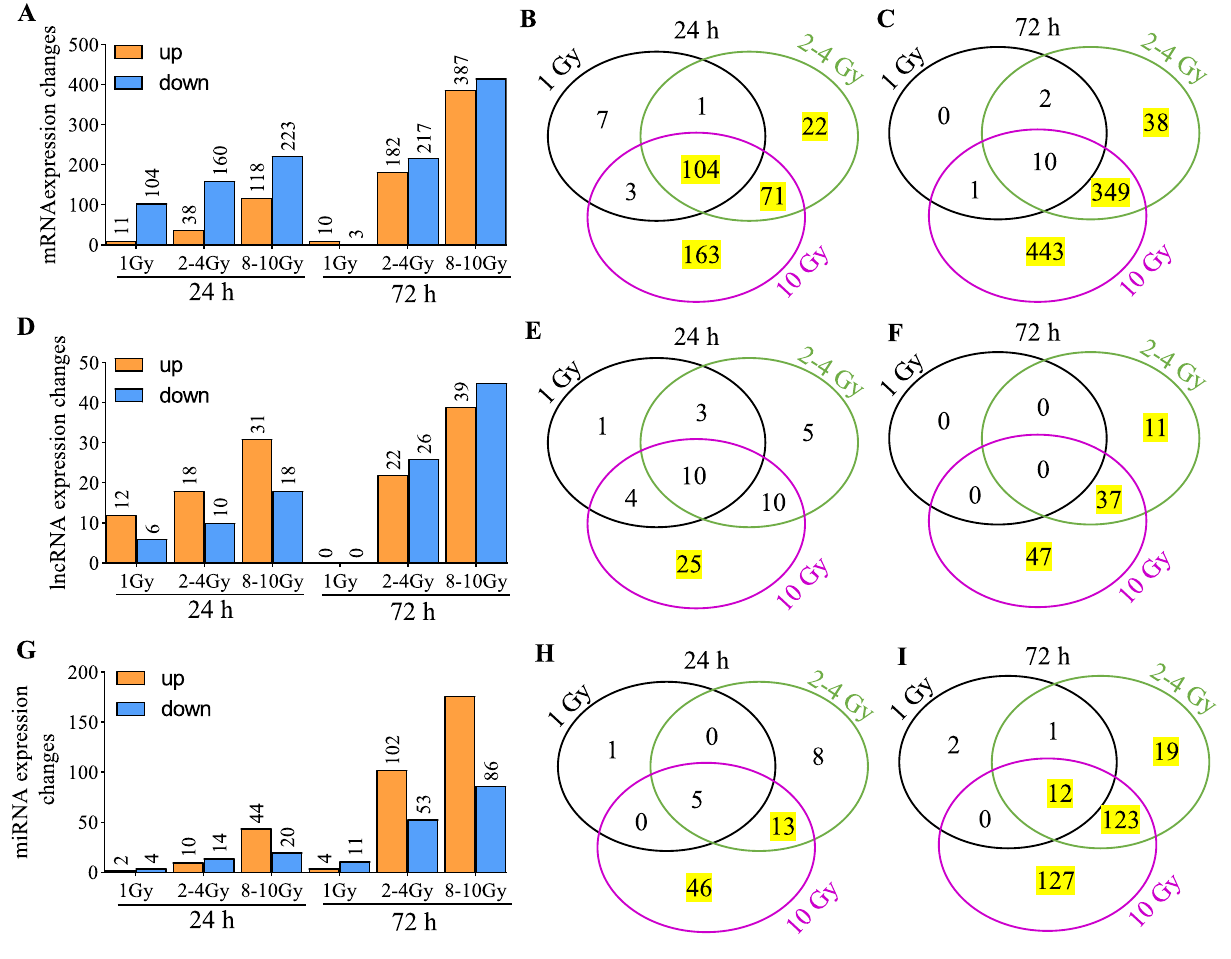
Figure 2. Summary of the differentially expressed RNAs when doses were grouped into three categories- 1 Gy, 2–4 Gy, and 8–10 Gy. Differentially expressed genes were identified as those fulfilling the criteria (FDR < 0.05; |FC|> 1.5). Genes which were induced are shown as orange bars and repressed genes are shown as blue bars in ( A,D,G ). ( A ) Differentially expressed mRNAs at 24 h and 72 h for 1 Gy, 2–4 Gy and 8–10 Gy, ( B ) Venn diagram showing overlaps across the upregulated mRNAs shown in ( A ), ( C ) Venn diagram showing overlaps across the downregulated mRNAs shown in ( A ). ( D ) Differentially expressed lncRNAs at 24 h and 72 h for 1 Gy, 2–4 Gy and 8–10 Gy, ( E ) Venn diagram showing overlaps across the upregulated mRNAs shown in ( D ), ( F ) Venn diagram showing overlaps across the downregulated mRNAs shown in ( D ). ( G ) Differentially expressed miRNAs at 24 h and 72 h for 1 Gy, 2–4 Gy and 8–10 Gy, ( H ) Venn diagram showing overlaps across the upregulated mRNAs shown in ( G ), ( I ) Venn diagram showing overlaps across the downregulated mRNAs shown in ( G ). All values greater than 10 are highlighted in